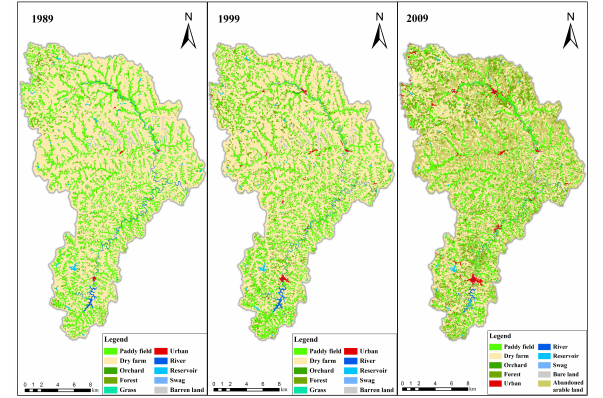
Figure 2 land use maps resulting from the integration of supervised classification and visual interpretation